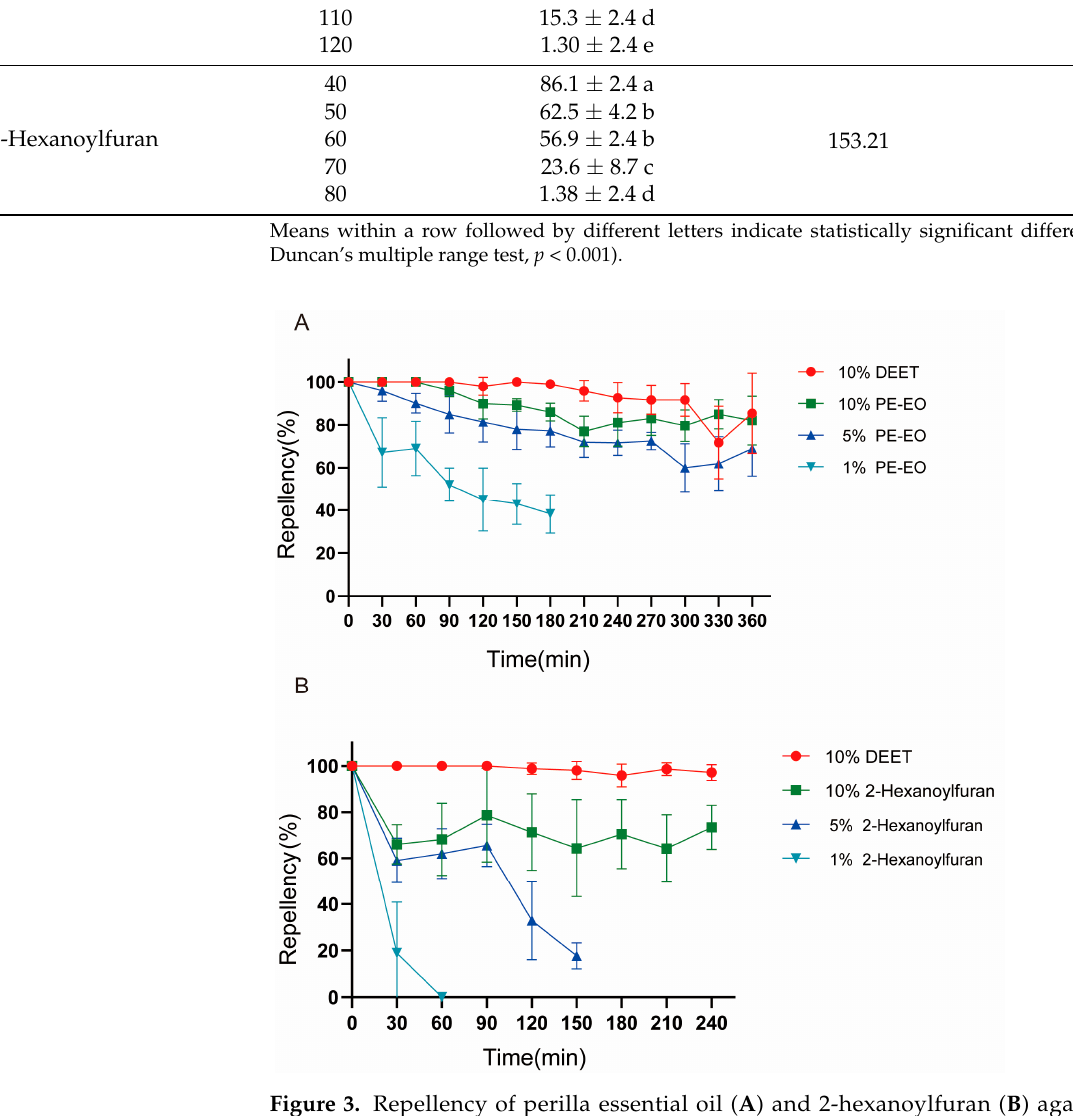
Figure 3. Repellency of perilla essential oil ( A ) and 2-hexanoylfuran ( B ) against Culex pipiens pallens adults .